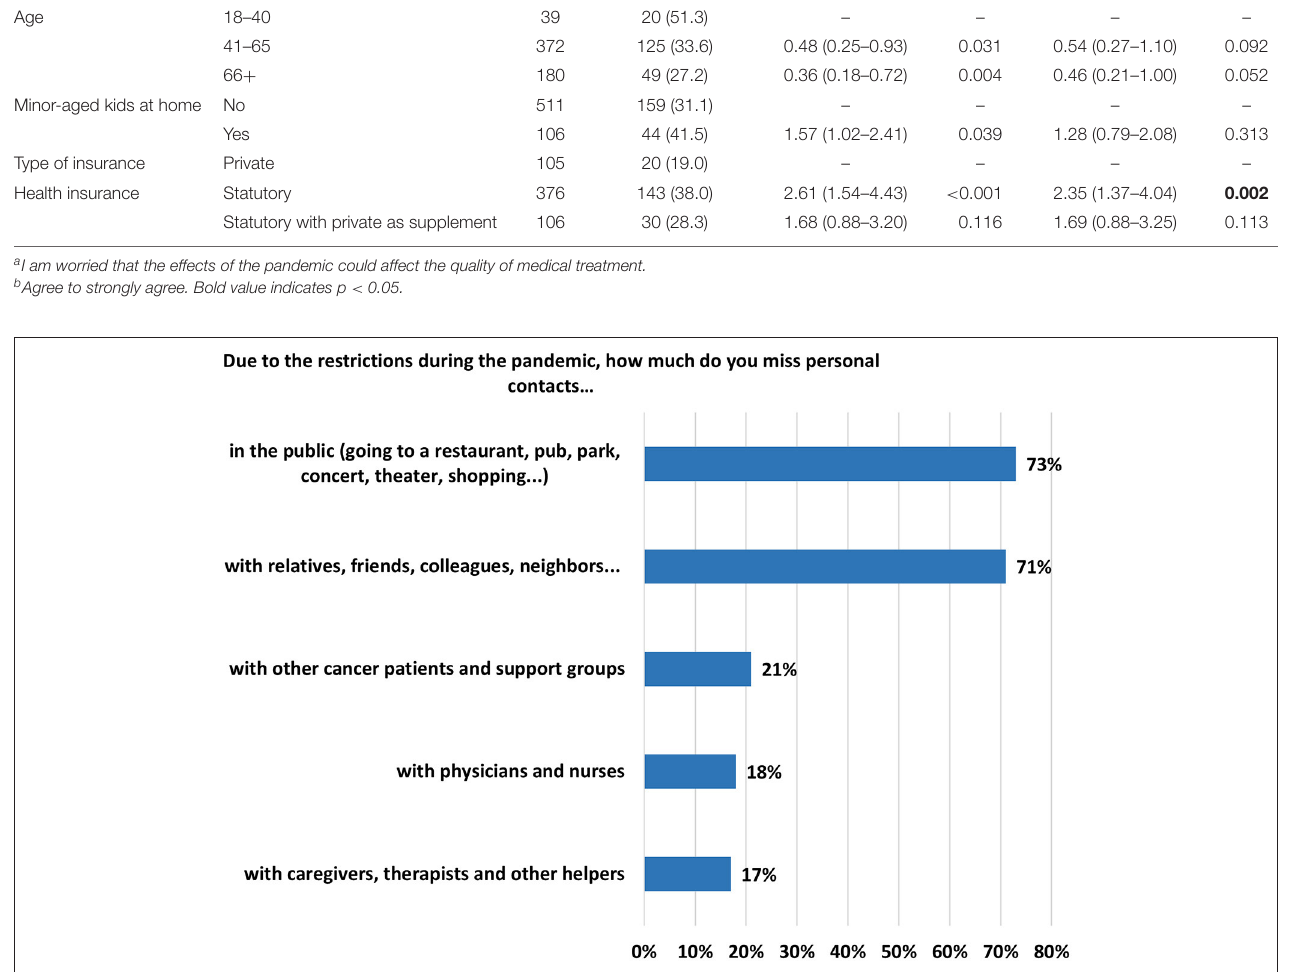
Unadjusted results